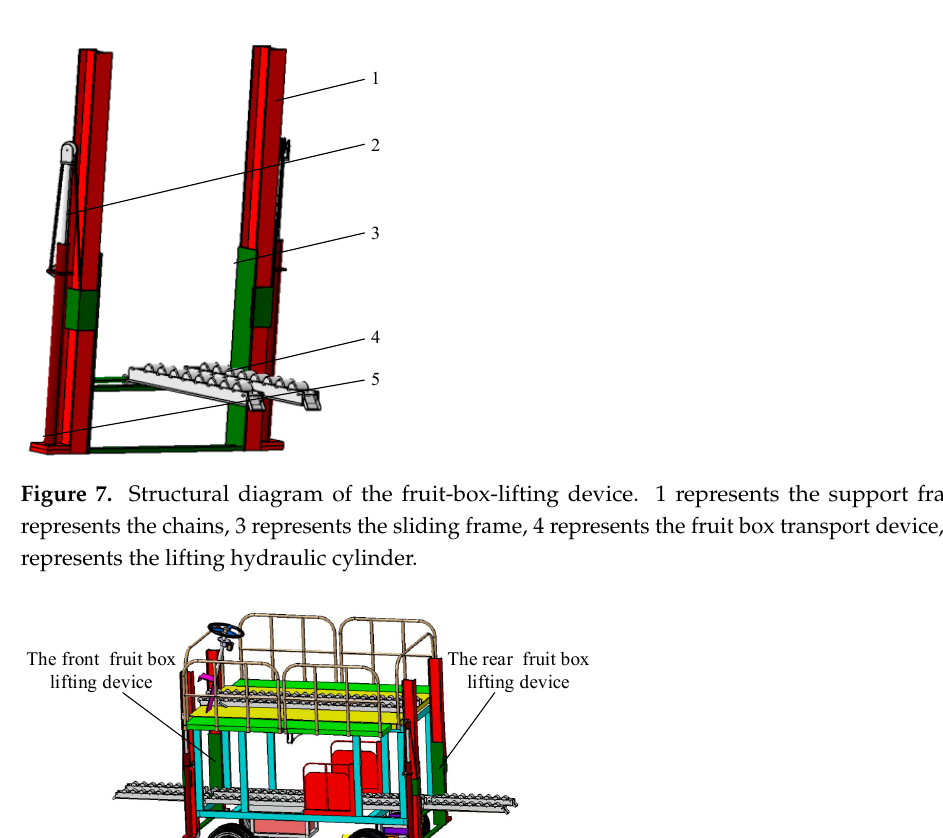
Figure 9. Diagram of power transmission.